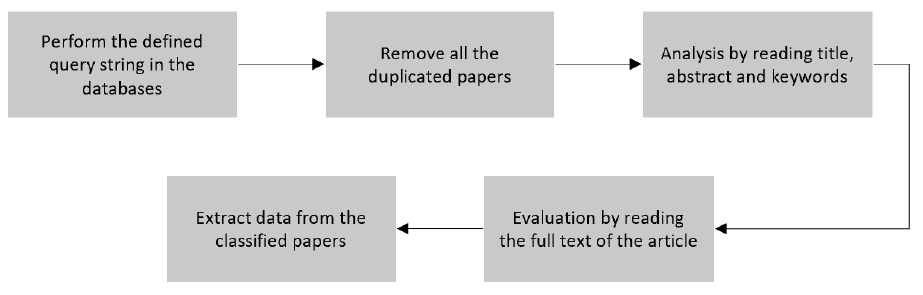
Figure 1. Conducting process. Source: